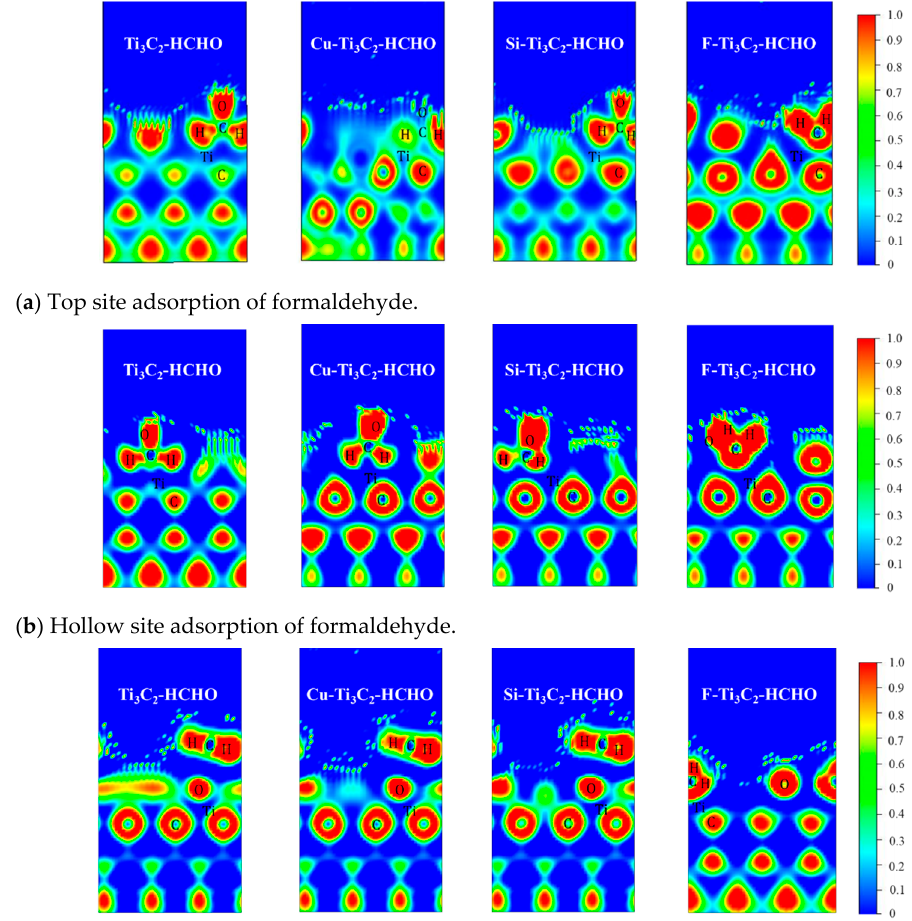
Figure 7. Electron localization function.